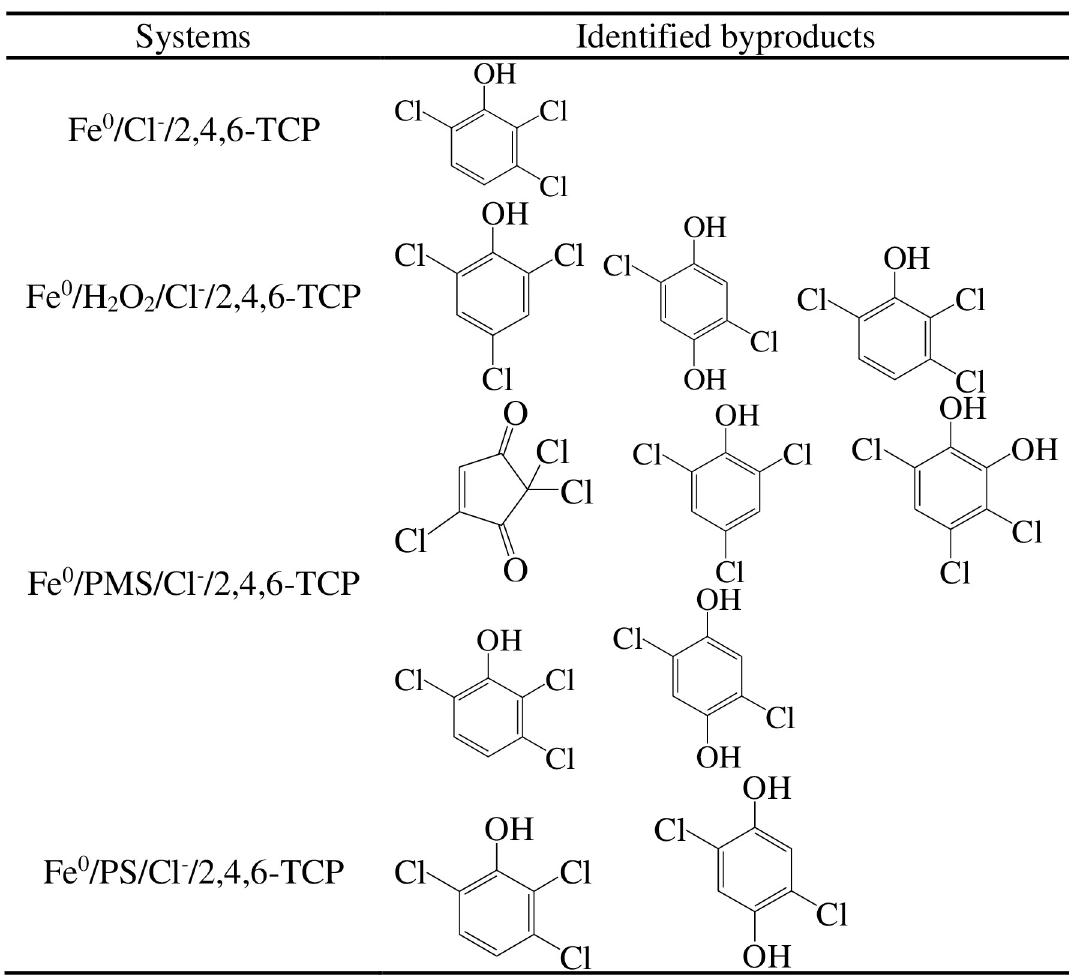
Fig 7. The transformation products of 2,4,6-TCP degradation in four systems (with Cl -